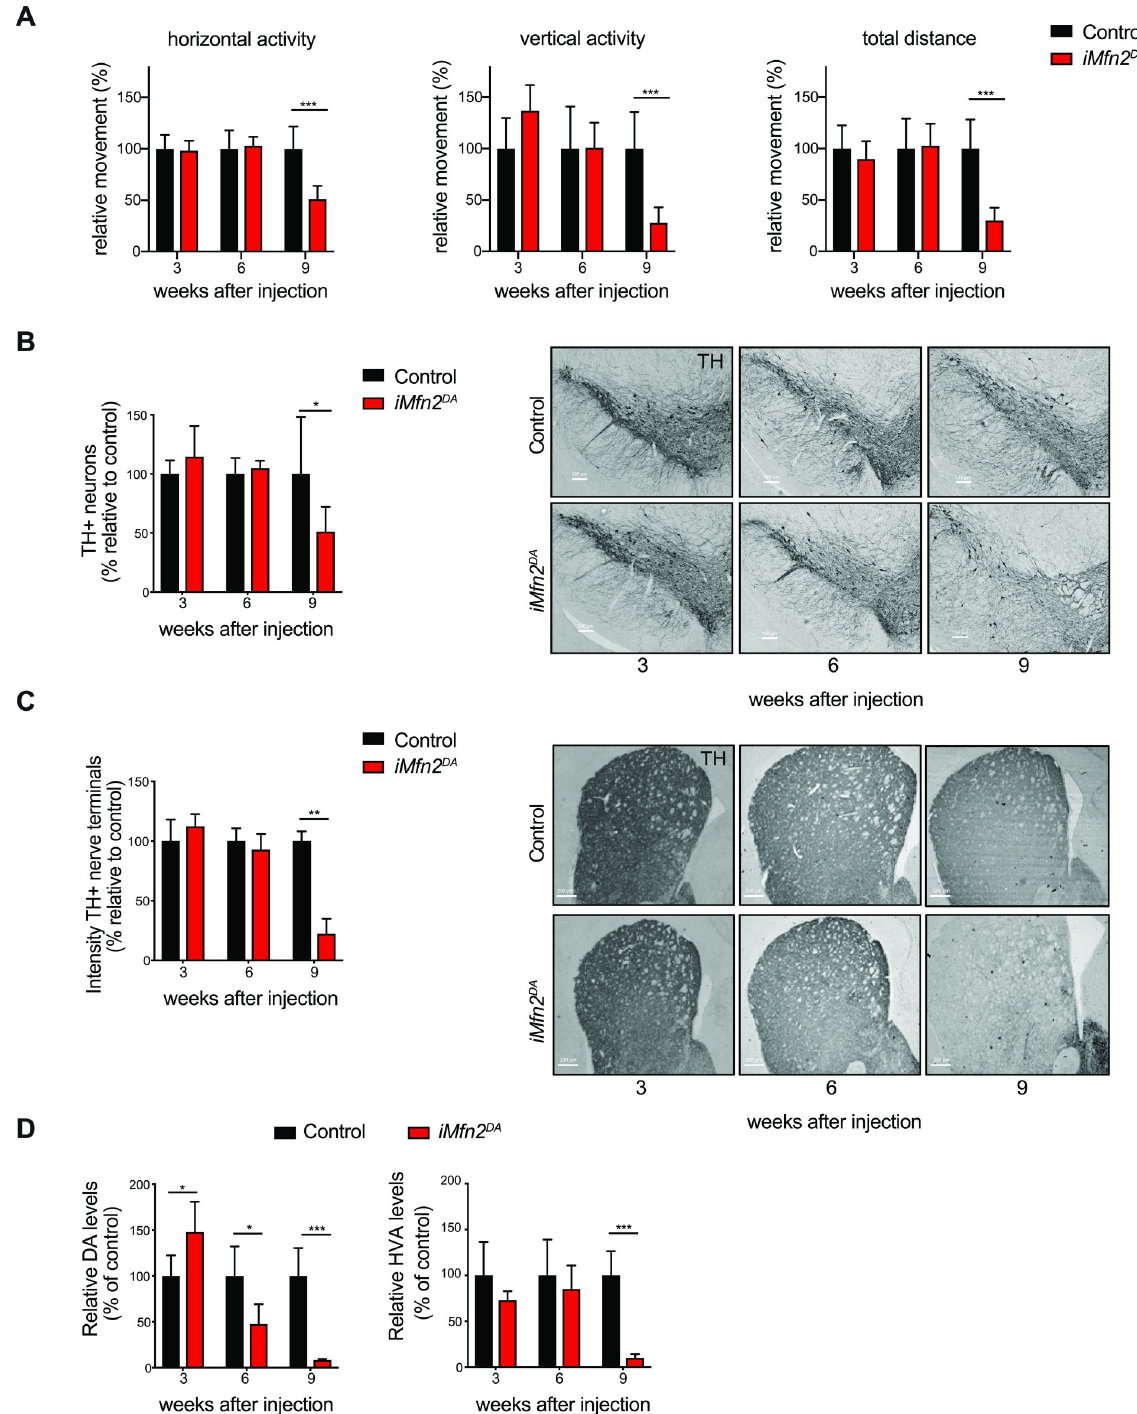
Fig 1. Tamoxifen-injected iMfn2 DA mice show impaired locomotion and DA neurodegeneration. Control and iMfn2 DA mice were analyzed at 3, 6 and 9 weeks after tamoxifen or vehicle injection. (A) Spontaneous motor activity (horizontal activity, vertical activity and total distance) was measured in open field. ��� p < 0.001, n > 14. (B-C) Representative images of TH-like immunoreactivity in section from midbrain (Scale bars: 100 μ m) and striatum (Scale bars: 200 μ m), right panels. Quantification of TH-positive DA neurons in the midbrain and TH- immunoreactive nerve terminals in the striatum, left panels. ��� p < 0.001 n = 3. (D) Analysis of DA and HVA levels in the striatum. Data are shown as mean ± SD. ��� p < 0.001 n � 5.